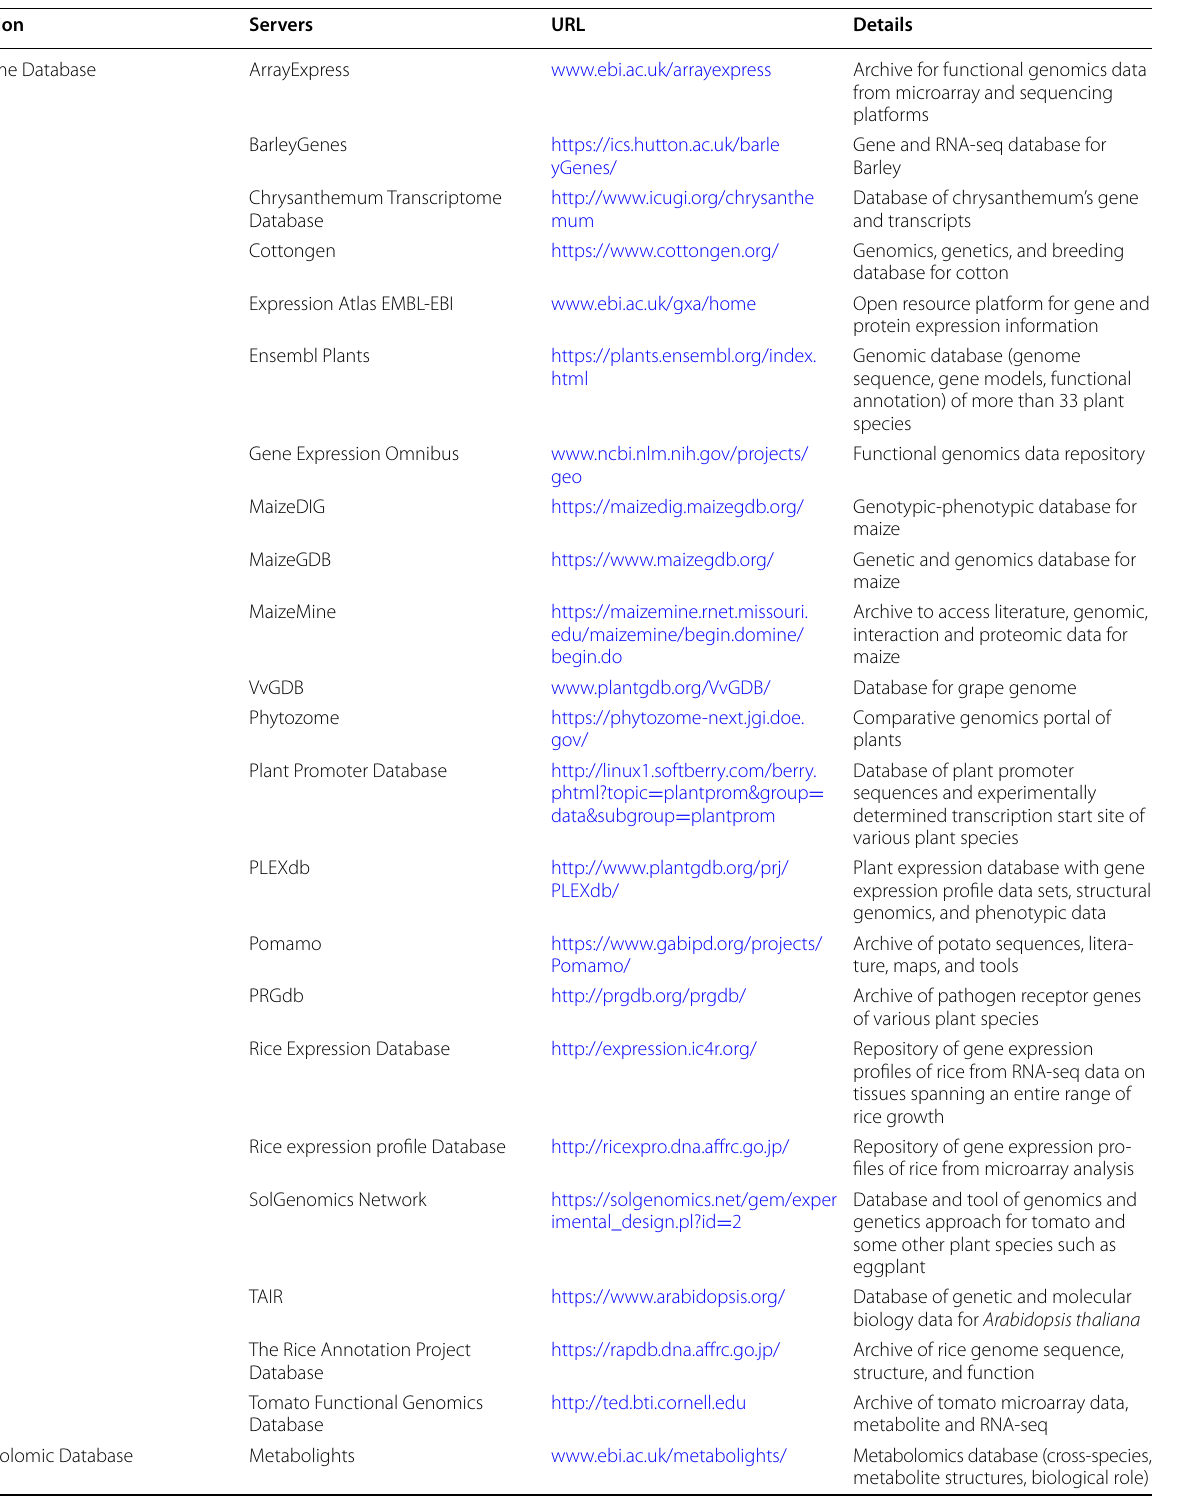
Table 1 List of bioinformatics databases and tools applied in plant biotechnology